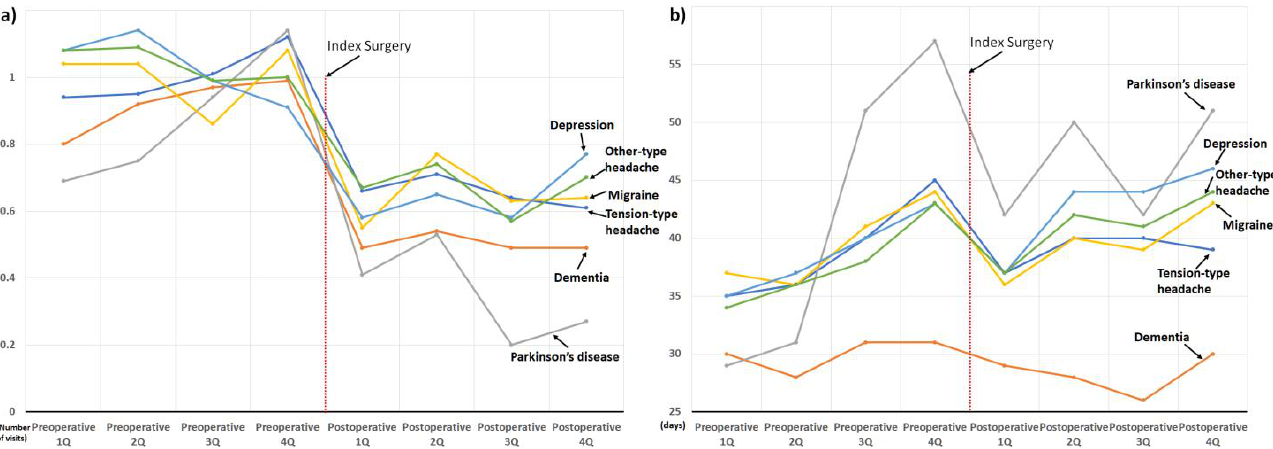
Figure 9. Perioperative changes in the use of sleep medication and hospital visits owing to sleep disorder according to the osteoarthritis of the extremities: ( a ) changes in the number of hospital visits, and ( b ) changes in the prescribed duration of sleep medication.